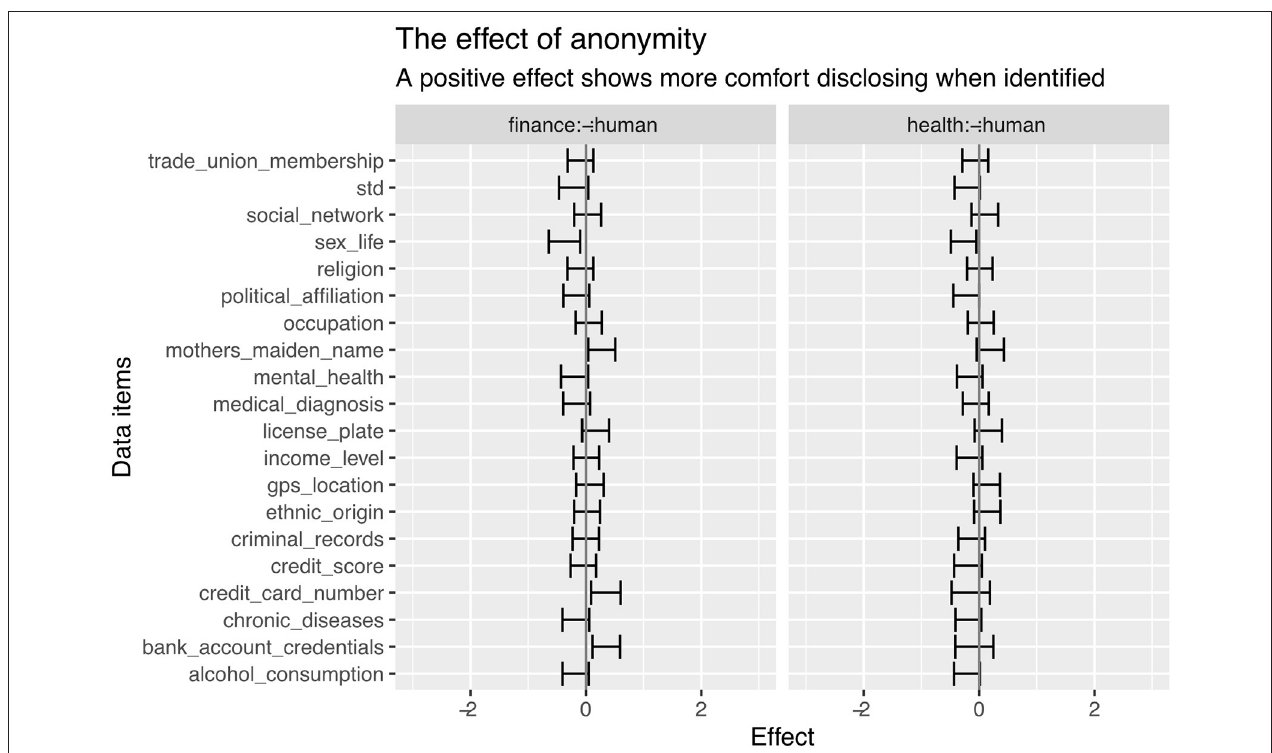
FIGURE 10 | The influence of anonymity across different scenarios of information